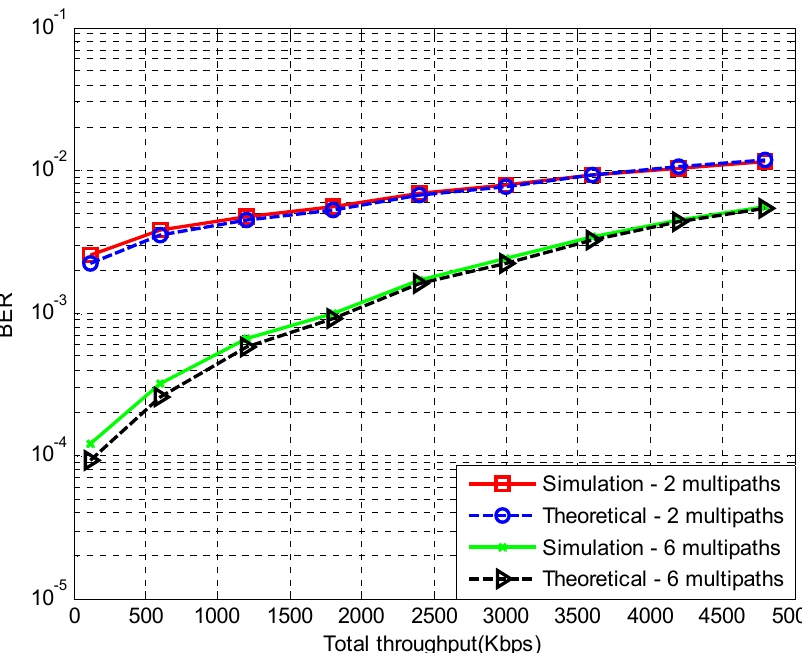
Figure A4. Simulation and theoretical BER for a 8 × 4 MIMO—WCDMA network.